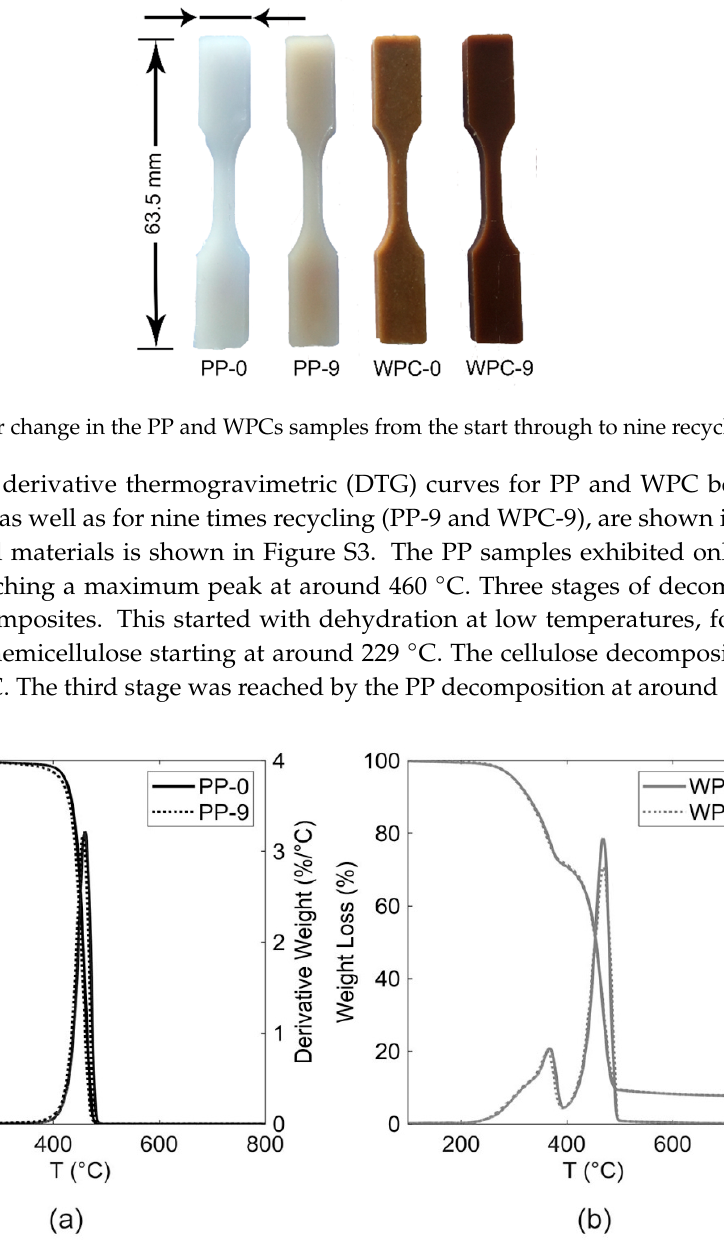
Figure 7. Thermo Gravimetric Analyzer (TGA) / derivative thermogravimetric (DTG) curves for ( a ) PP and ( b ) WPCs before and after nine recycles.